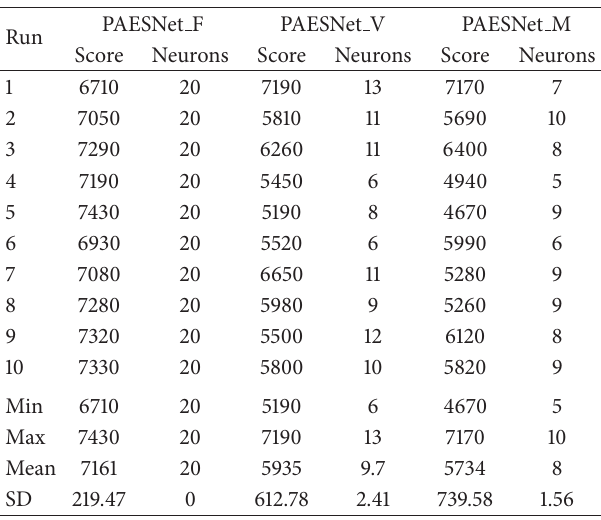
Table 1: The training results.